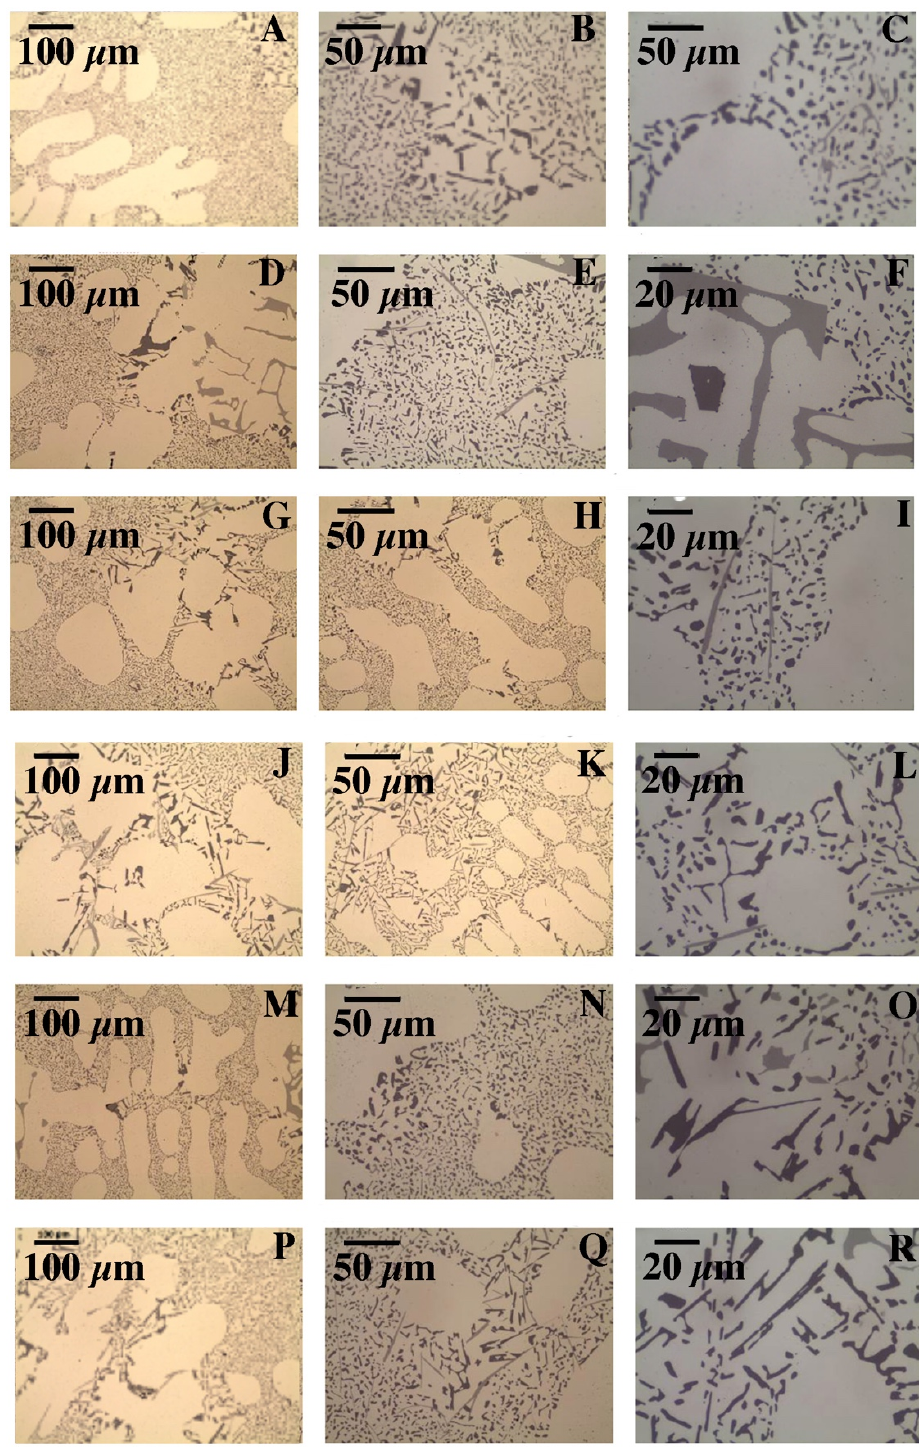
Figure 9. Microstructure of cast samples before and after heat treatment (LC): ( A ) after casting, ( B , C ) after supersaturation, ( D – F ) after supersaturation and ageing—2 h, ( G – I ) after supersaturation and ageing—4 h, ( J – L ) after supersaturation and ageing—6 h, ( M – O ) after supersaturation and ageing—8 h and ( P – R ) after supersaturation and ageing—16 h.